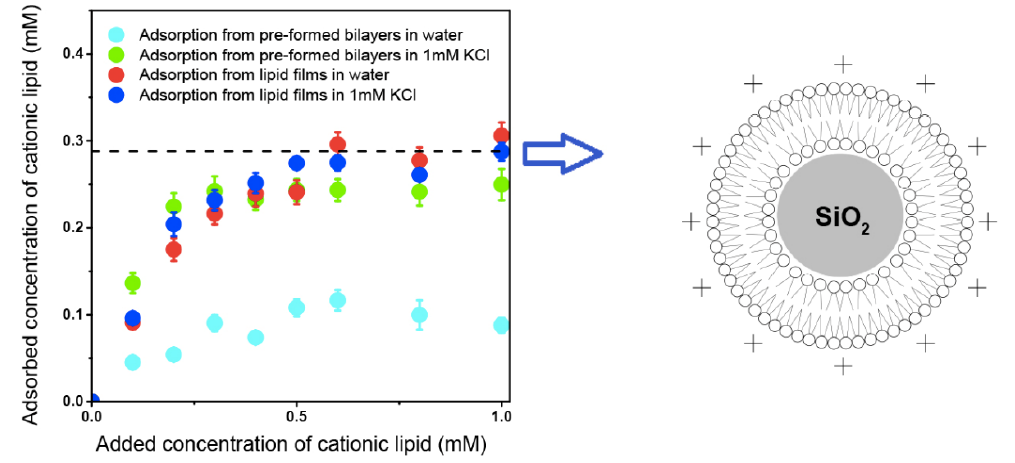
Figure 18. Adsorption isotherms for DODAB from films or pre-formed bilayer fragments (BF) onto silica (2 mg/mL). The dashed line at 0.288 mM DODAB represents the theoretical concentration corresponding to bilayer adsorption. Reproduced from [209].